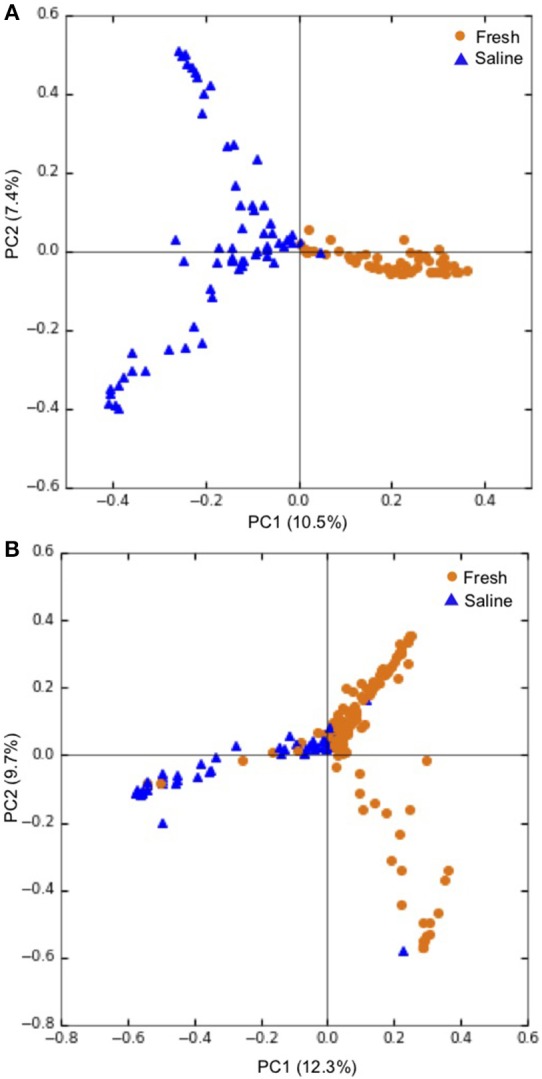
Principal coordinate analysis (PCoA) showing grouping of (A) individual skin microbiomes at fresh (n = 55), and saline (n = 63) sites and (B) individual intestinal microbiomes at fresh (n = 144) and saline (n = 58) sites. PCoA ordinations are based on the Bray-Curtis dissimilarity metric. Freshwater sites include lake and river sites sampled in winter and spring while saline sites refer to sea shoreline locations sampled in autumn during the annual char run.